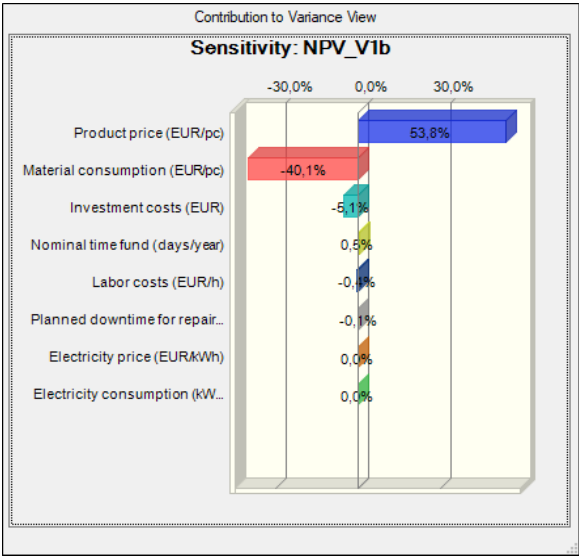
Figure 10. Graph of sensitivity of risk factors to NPV_V1b.